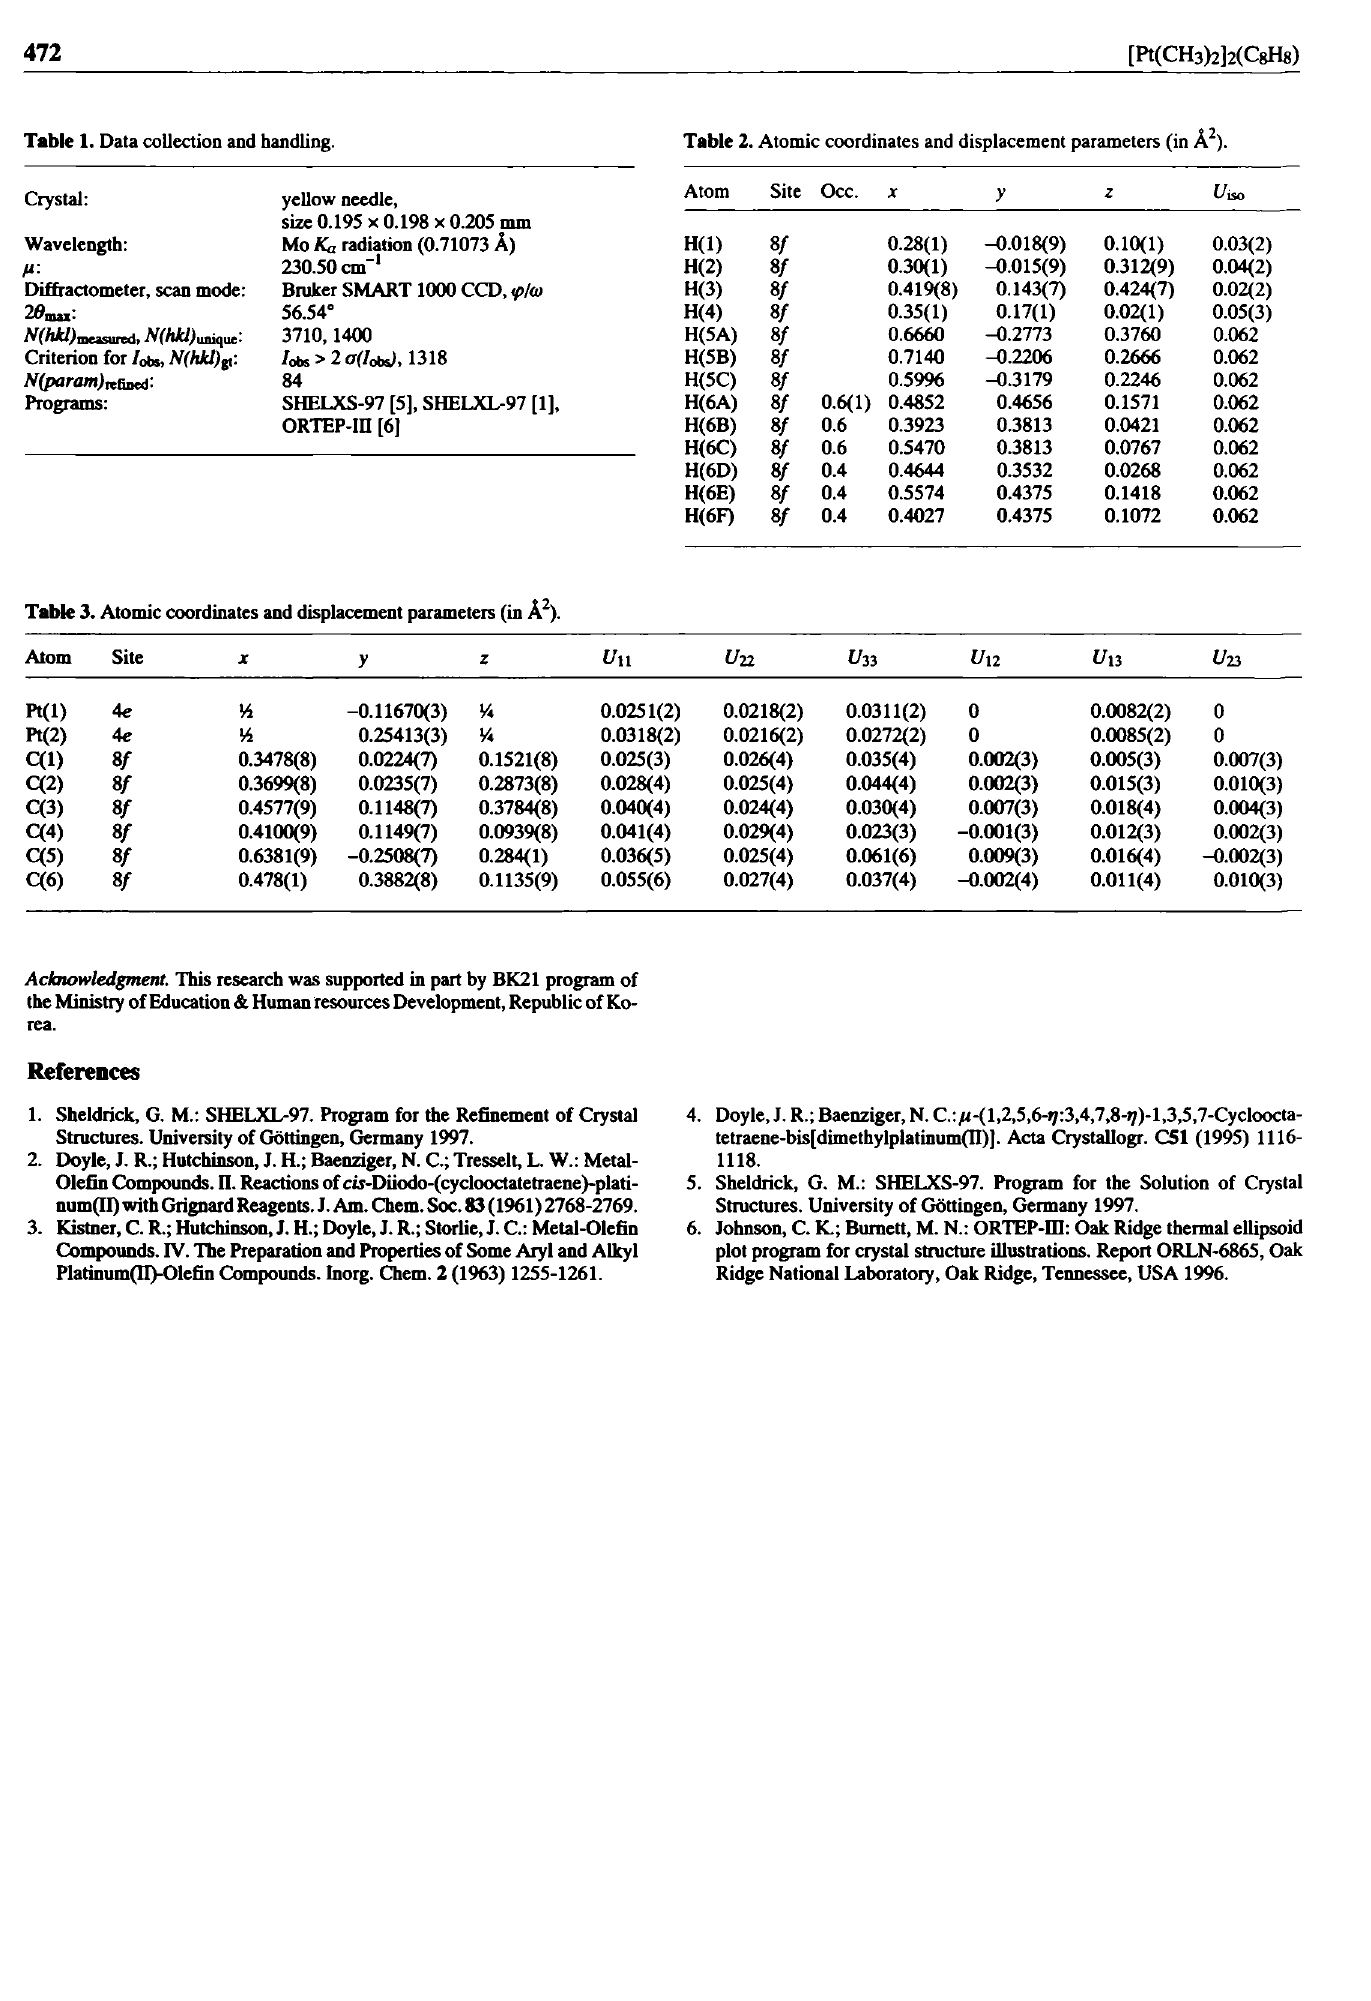
Table 1. Data collection and handling. Table 2. Atomic coordinates and displacement parameters (in Ä 2 ).